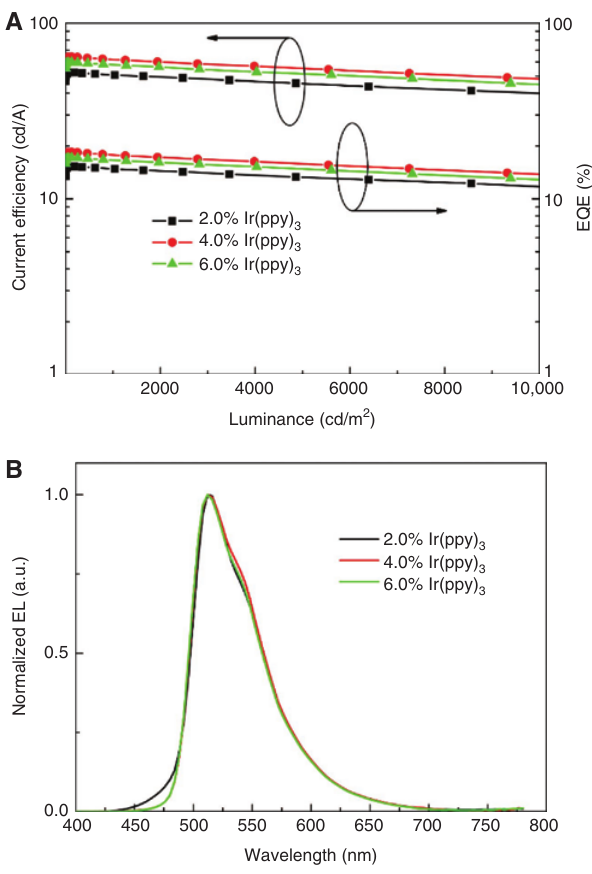
Figure 4: The EL performance of Ph-OLEDs with different Ir(ppy) concentrations. (A) The current efficiency-luminance-EQE curves. (B) The EL